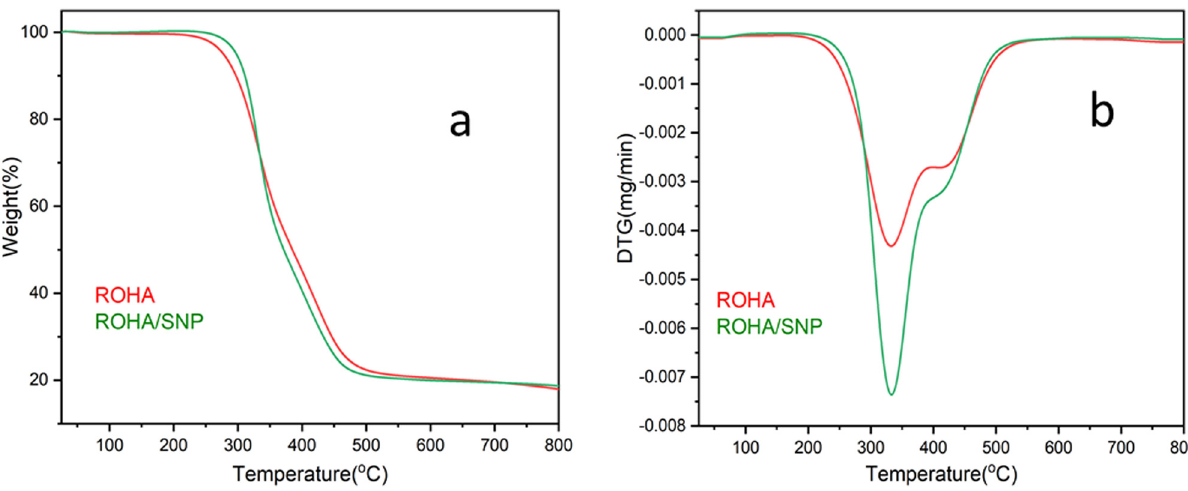
Figure 11: TGA ( a ) /DTG ( b ) thermogram of ROHA and ROHA/SNP